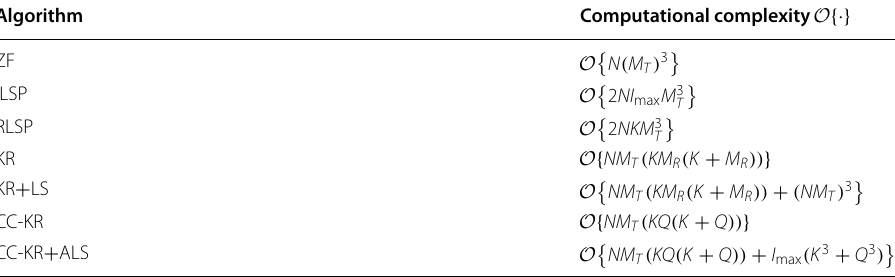
Table 2 Computational cost of compared algorithms